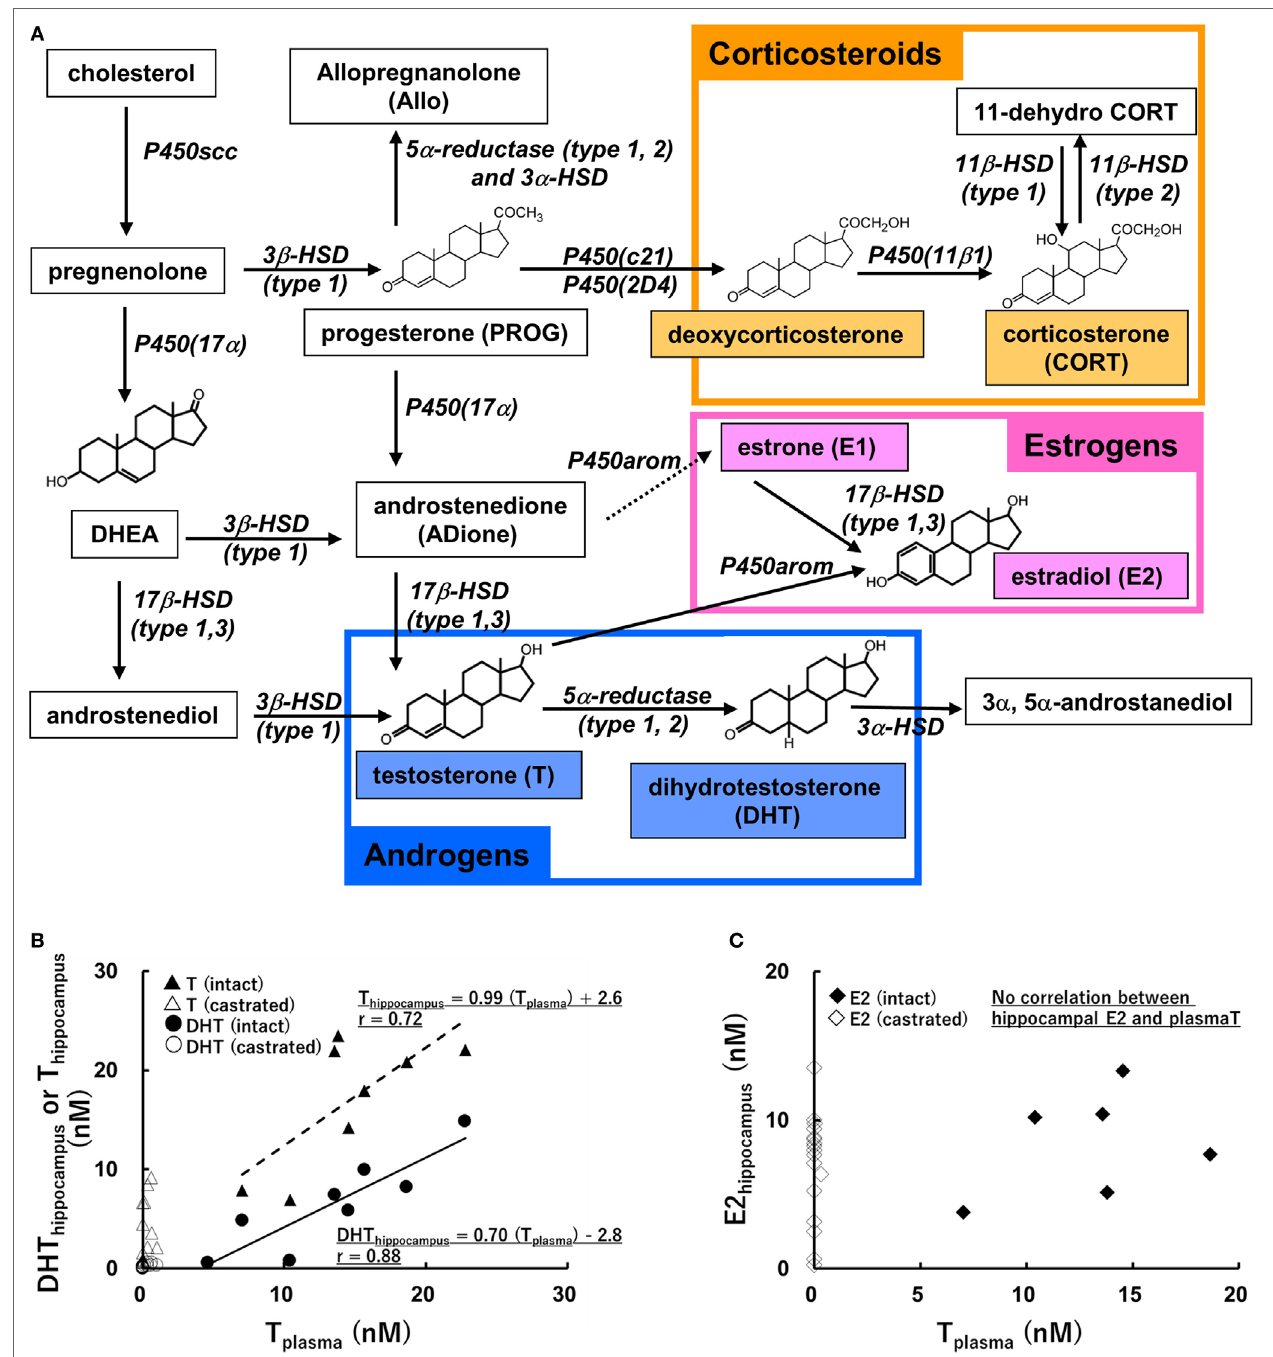
FigURe 1 | (A) Biosynthetic pathway of steroids in rat hippocampus [modified from Ref. (11)]. Estrogens, androgens, and corticosteroids are represented with pink, blue, and orange boxes, respectively. (B,C) Relationship between the level of plasma T and those of hippocampal androgens [T and dihydrotestosteron (DHT)] (A) , or that of hippocampal E2 (B) . Vertical axis represents hippocampal steroids and horizontal axis represents plasma T, a precursor of DHT and E2. The regression lines and Pearson’s “ r ” are indicated [modified from Ref. (37)].